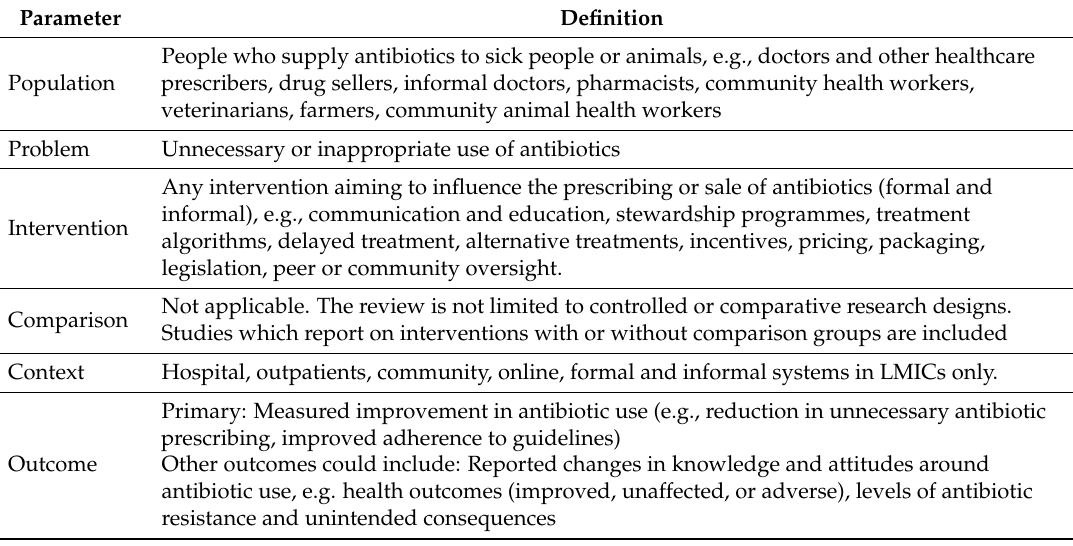
Table A1. Search